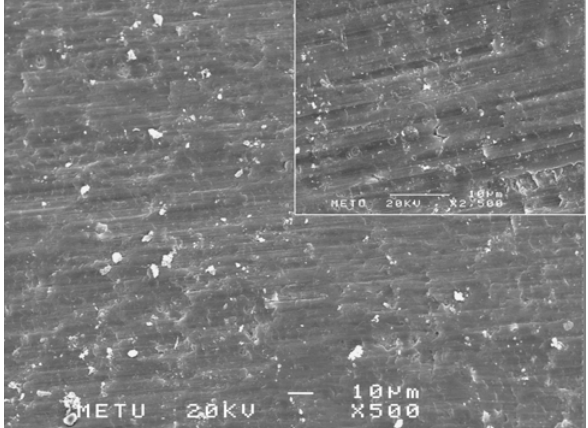
FIGURE 1- SEM analysis of the enamel surface after using 12-fluted tungsten carbide bur